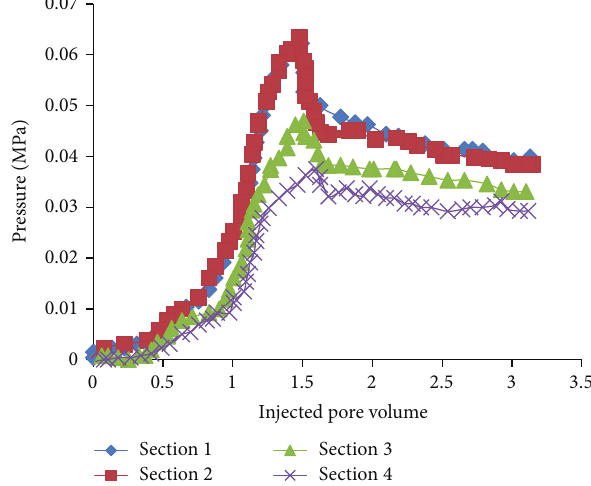
Figure 11: The plot of the injection pressure (diameter: 0.02 mm, concentration: 5000 mg/L).